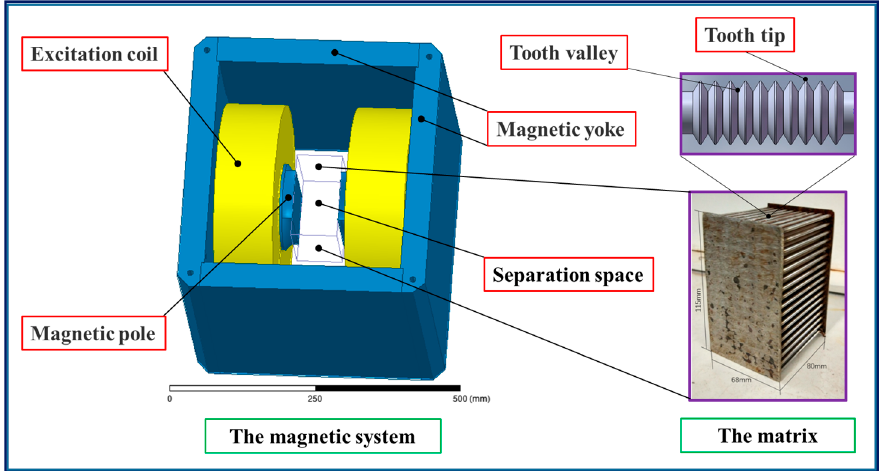
Figure 6. Simulation model of the magnetic system. Table 2. Material of the physical model.